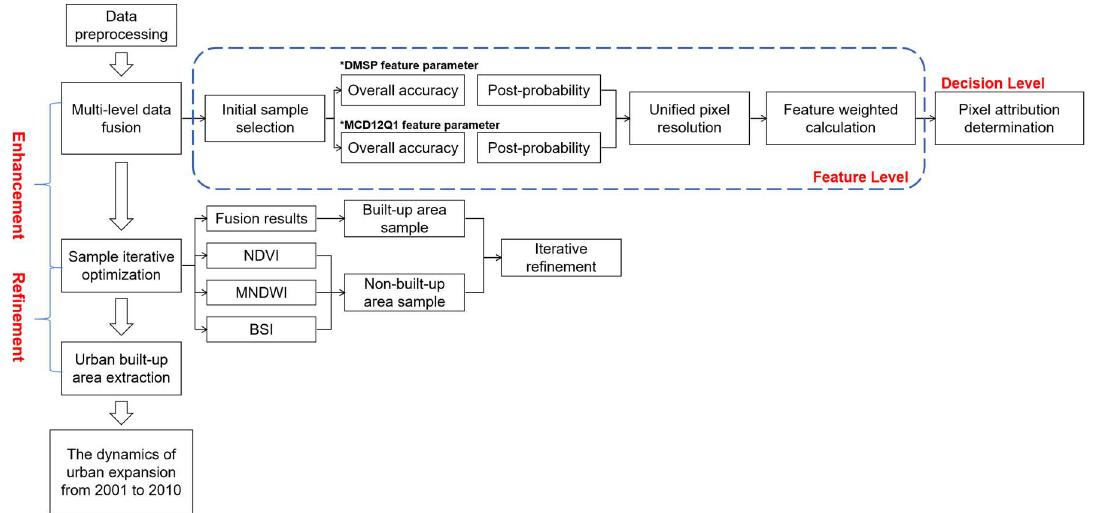
Figure 2. Flowchart of the proposed approach.